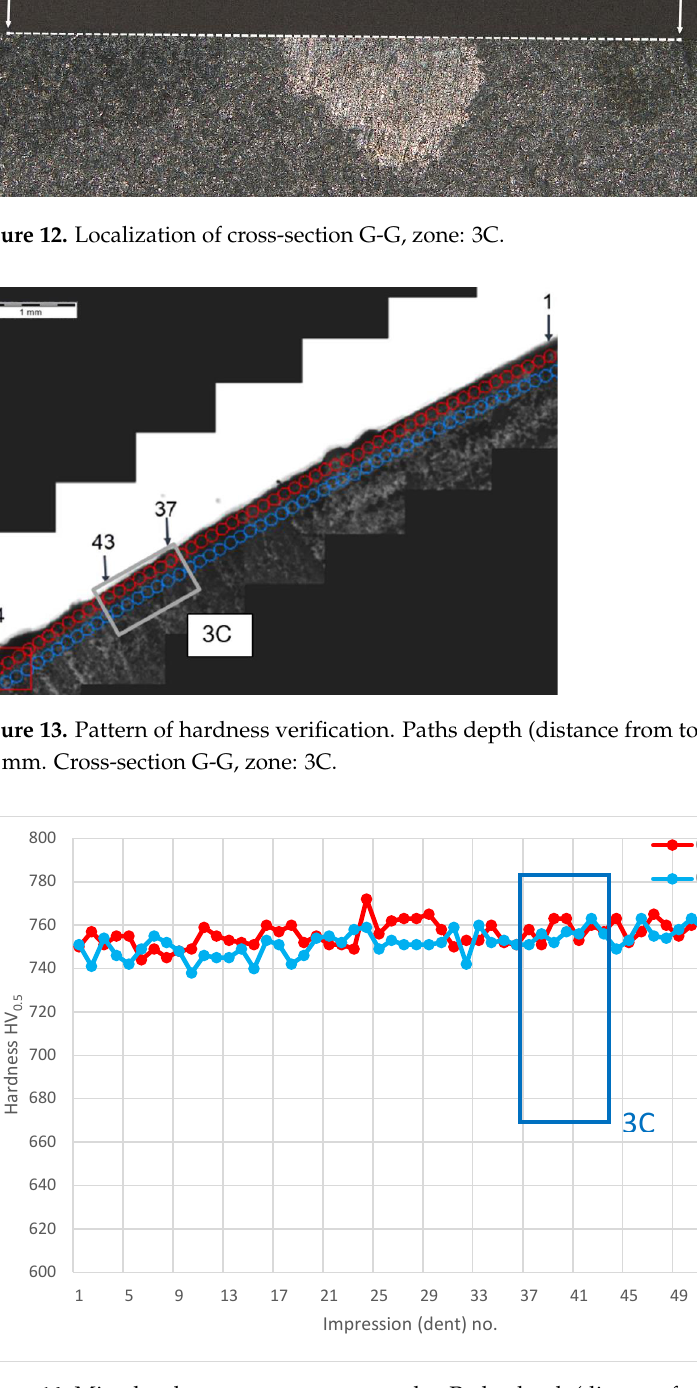
Figure 14. Microhardness measurement results. Paths depth (distance from tooth surface): 0.1 mm and 0.3 mm. Cross-section G-G, zone: 3C.